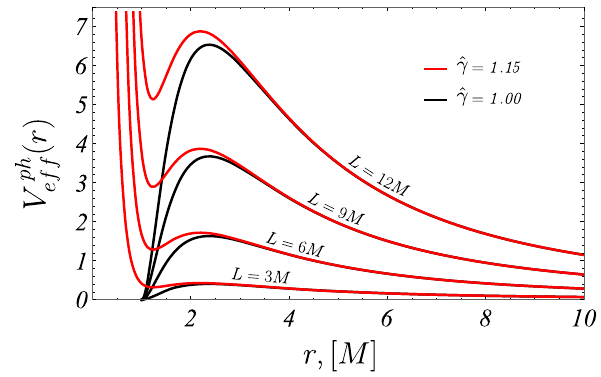
Fig. 1 Effective potential for the null geodesics for the Gauss–Bonnet black holes with ˆ γ = 1 and weakly naked singularities with ˆ γ = 1 . 15